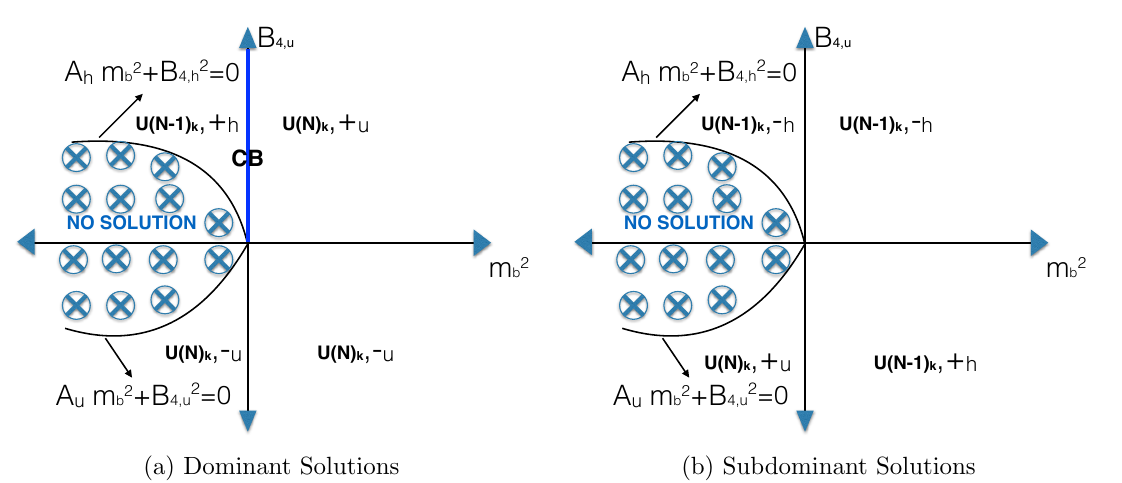
Figure 27. Graphs of the domain of existence of the dominant and subdominant solutions to the gap equation for x 6 < (cid:30) 1 . The dominant and subdominant solutions merge along the two parabolas in the graphs above. No solution region is marked with blue crosses in the (cid:12)gure. The solution space may thus be thought of as a double cover of the compliment of the uncrossed portion of the m 2 - B 4 ;u plane. b